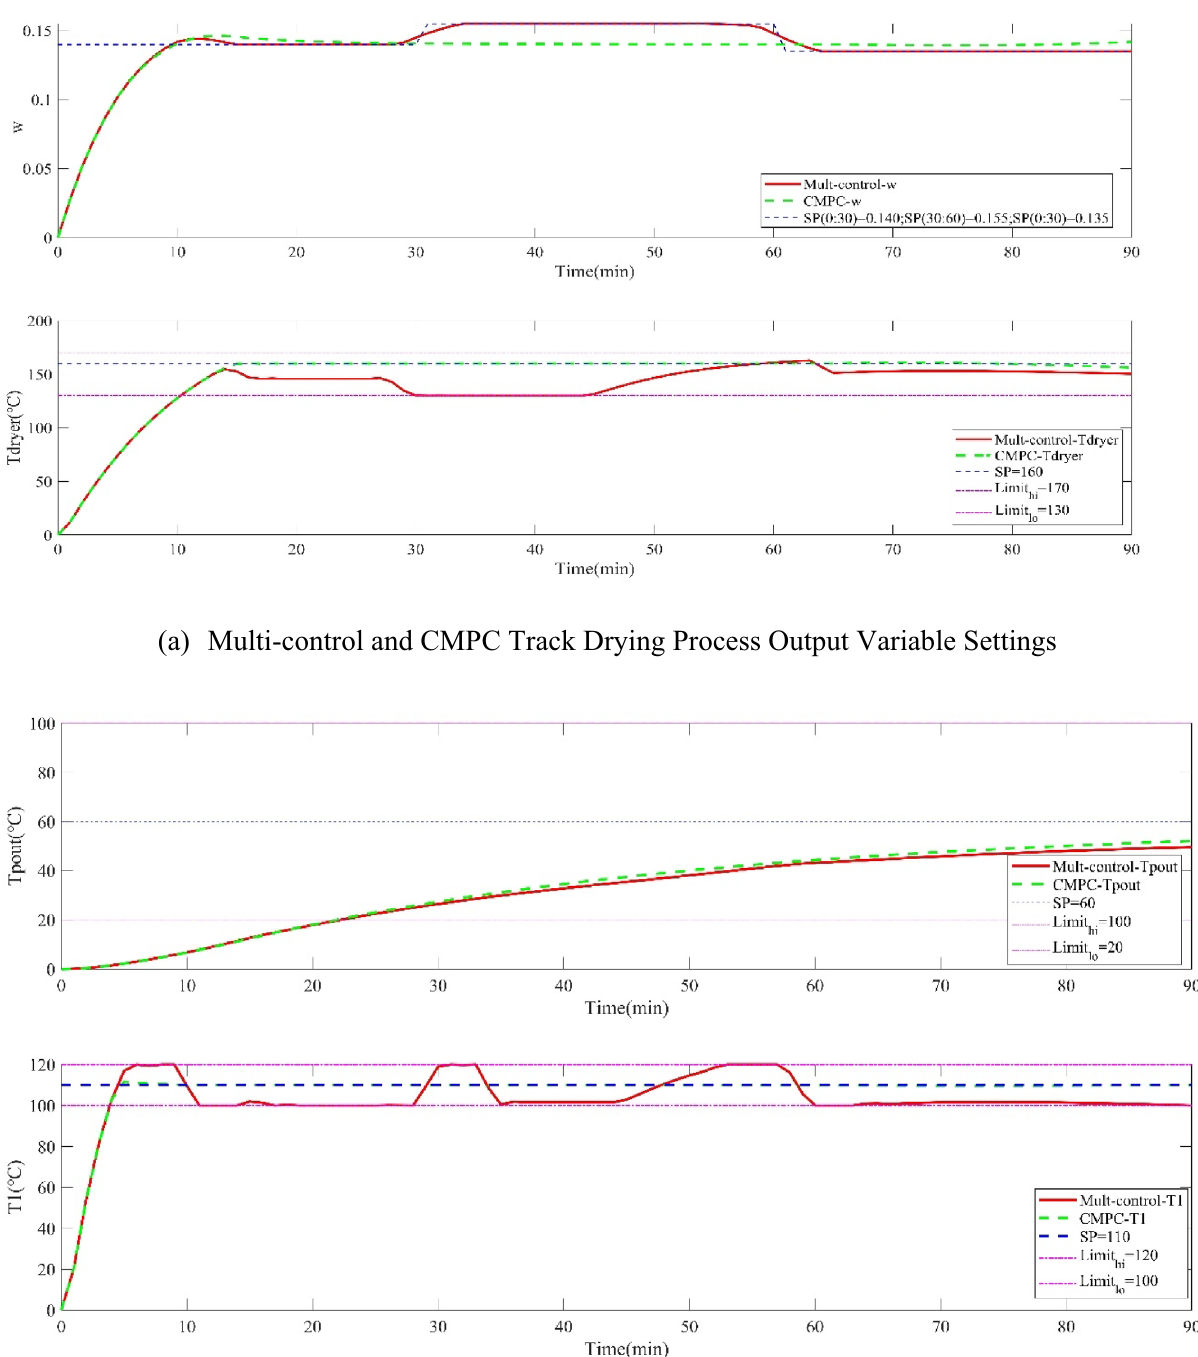
Figure 4. Multi-control and CMPC tracking optimization of tobacco drying process under nominal